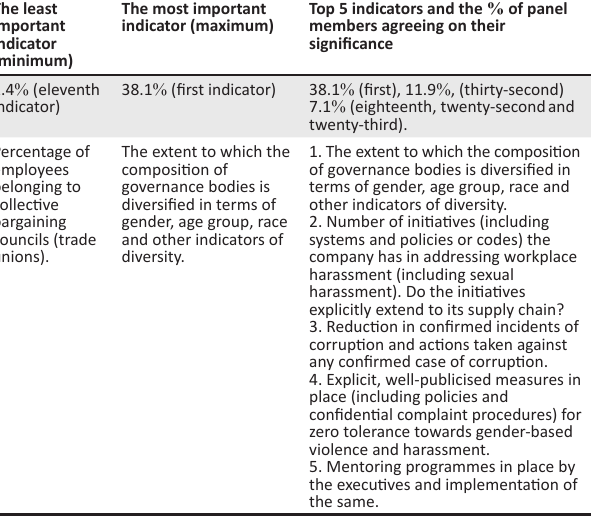
TABLE 4: Governance pillar indicators from the third